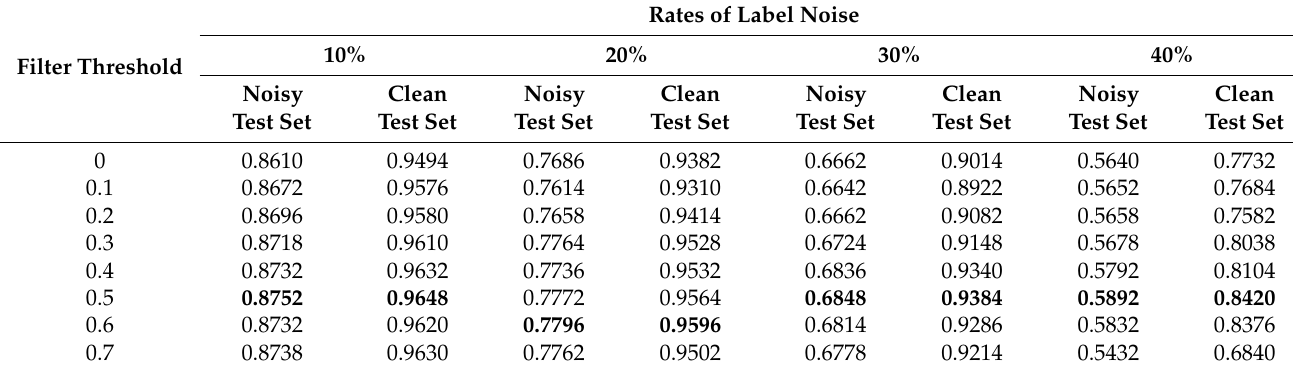
Table 1. Accuracy of ResNet18 classification for cassava leaf disease with various noise